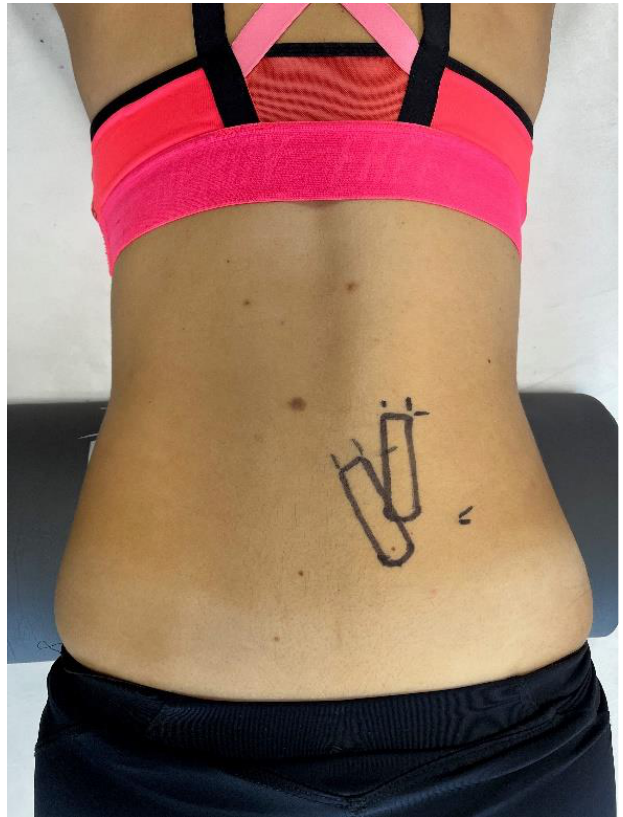
Figure 2. Example of marks drawn with semi-permanent marker. Measurements of shear modulus were completed at rest and during two submaximal contractions of the trunk extensors at different intensities: the prone arm lift (low-level contraction; Figure 3A) and trunk extension (high-level contraction Figure 3B). For the former, participants laid prone with their legs supported on a pillow. Furthermore, a small pillow was placed under the participants pelvis to rotate it posteriorly and flatten the lumbar curve. For the prone arm lift (low-level contraction), the position was the same as during rest. The shoulders were abducted to 120 ◦ , and the elbows were flexed at 90 ◦ . The lower legs were fixated using a strap belt to prevent lower limb movement during the arm lift. The participants were instructed to lift the contralateral arm while holding a 0.5 kg plate approximately 5 cm above the table and holding this position during the measurement. This procedure has been used before and produced highly reliable shear modulus values [14]. For trunk extension (high-level contraction), we used the Biering-Sorensen test position, as used in previous studies [36]. The participants were positioned with their trunk over the edge of the table, while the pelvis and legs were manually fixated on the table by the researcher. For reference, the superior anterior iliac spines were positioned above the edge of the table. The participants were instructed to lift the upper body by extending the hip to a neutral position (0 ◦ hip extension) with their arms crossed on their chest and holding this position. During both submaximal contractions, a thin rope was used for external reference to enable the standardization of measurement at different time